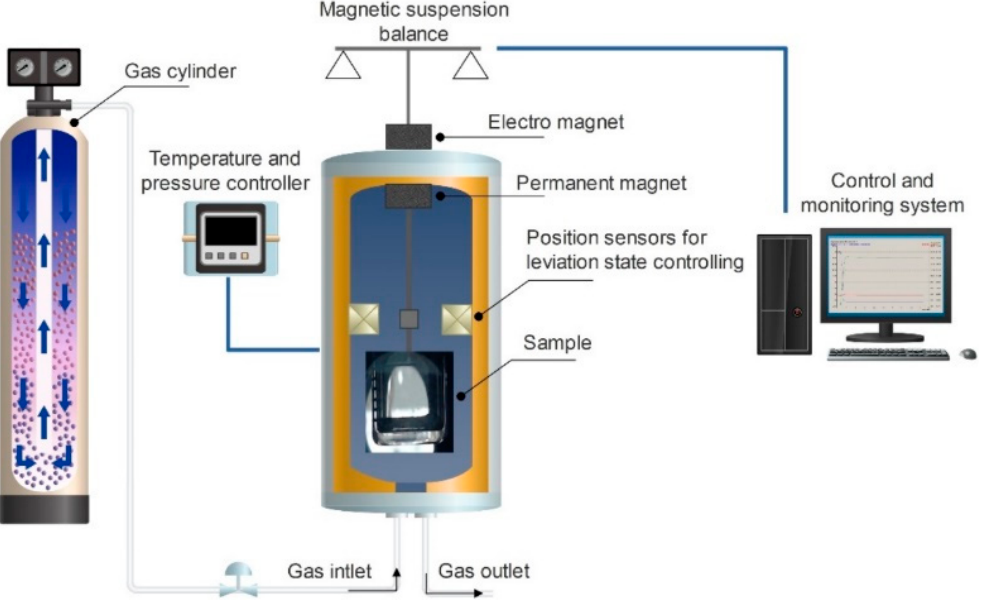
Figure 1. Schematic presentation of the magnetic suspension balance.